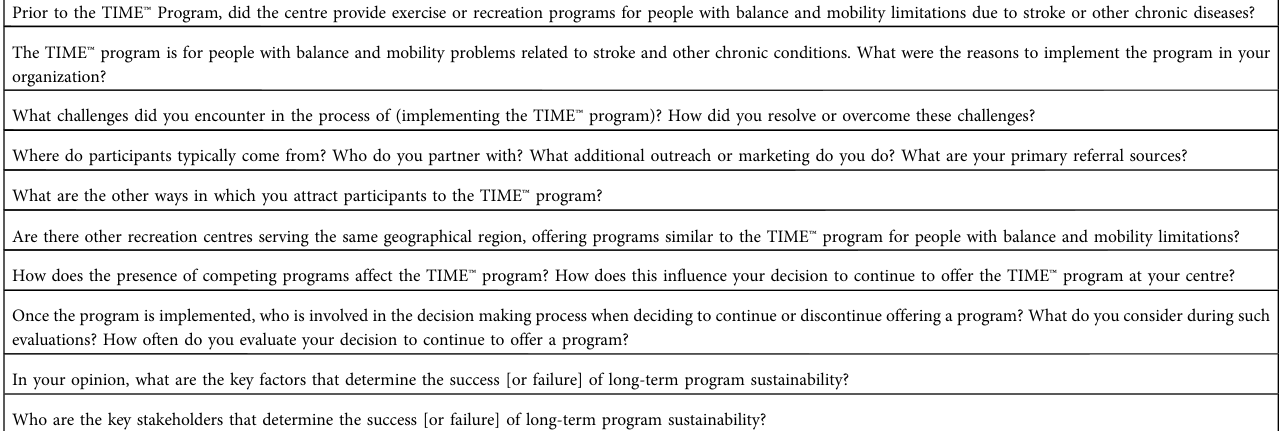
TABLE 2 Sample questions from interview guide for program